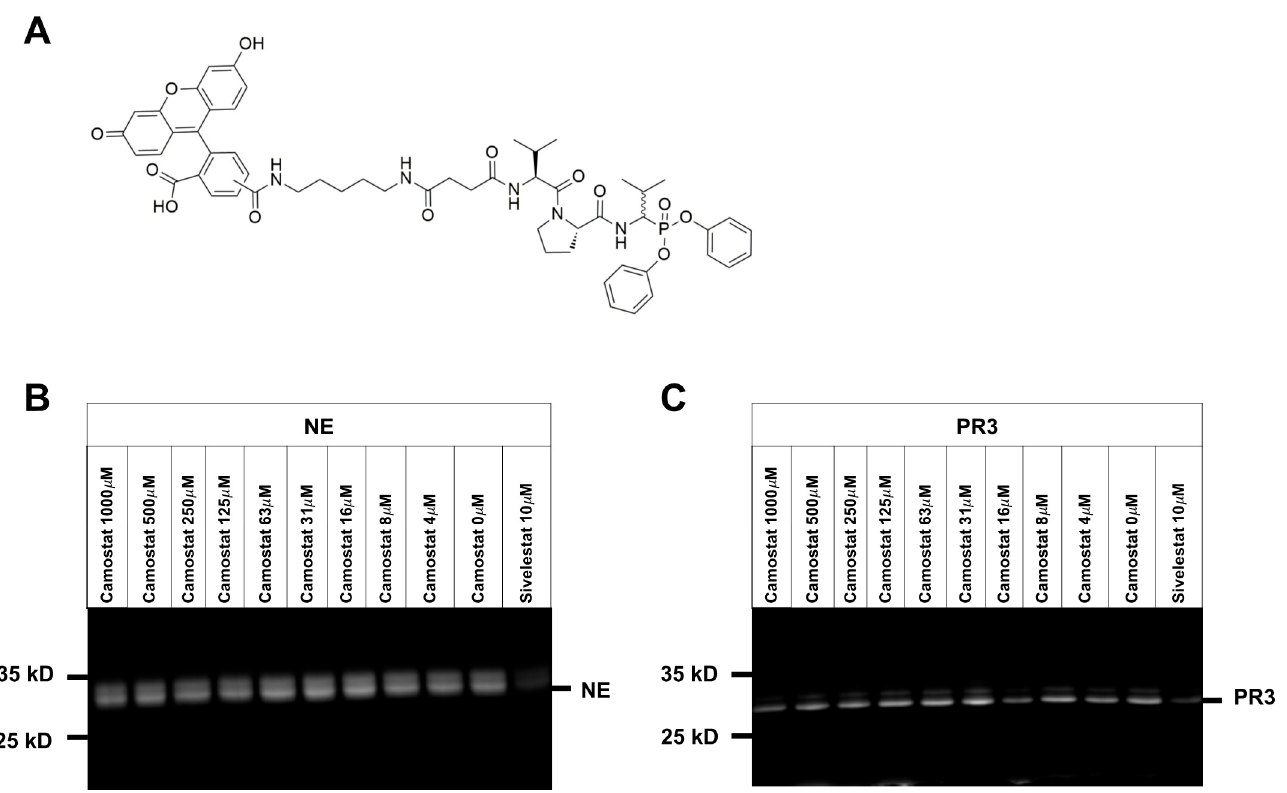
Figure 2. The inhibition capacity of camostat towards NE and PR3 was analyzed by using activity- based protein profiling. ( A ) Structure of activity-based probe FAM-DAPe-Suc-Val-Pro-Val P (OPh) 2 (VPV-FAM). ( B ) Activity-based protein profiling of NE and ( C ) PR3 by using VPV-FAM with indicated concentrations of camostat was performed. 10 μ M of sivelestat was used as an inhibitor for NE and PR3. One representative gel out of three ( n = 3) experiments is shown.